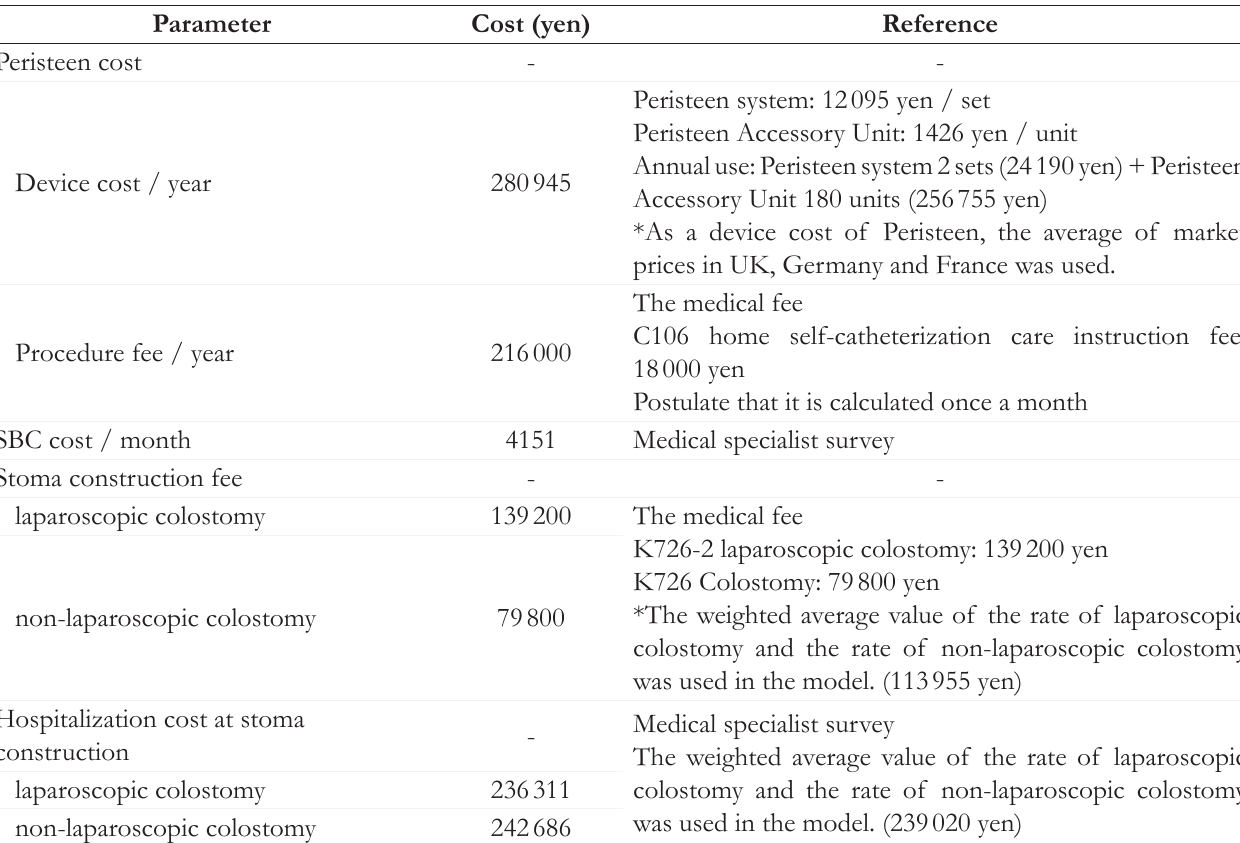
Table 4. Cost Parameters